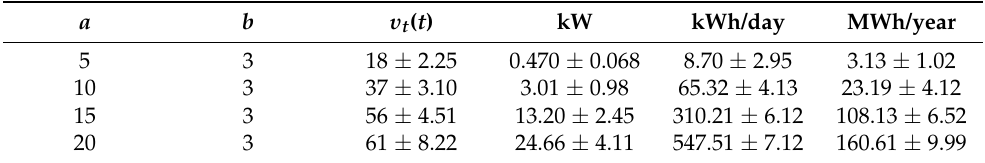
Table 1. Numerical results of the power generated for different chamber dimensions considering the mean values of wave height and period. Table 2. Numerical results of the power generated for different chamber dimensions considering the probability density function of wave height and